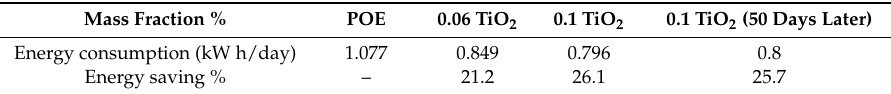
Table 3. Energy consumption of HFC134a/POE oil and HFC134a/mineral oil/TiO 2 nanoparticle systems